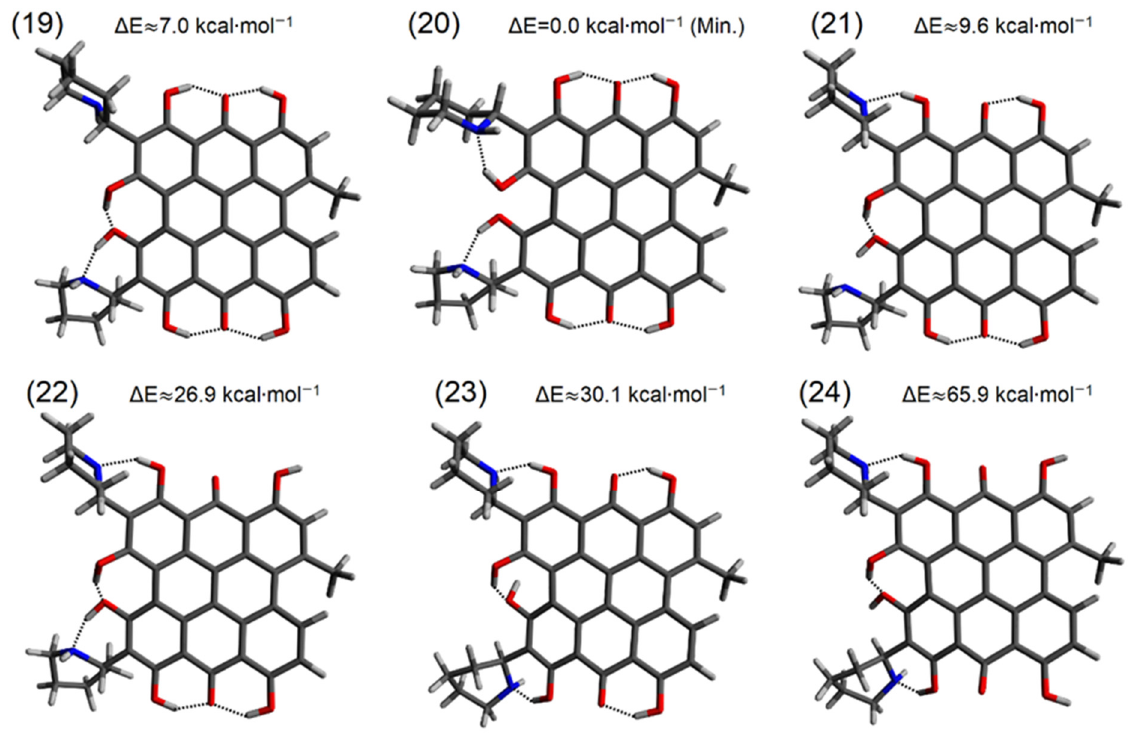
Figure 4. Conformers (19–24) of fagopyrin D.